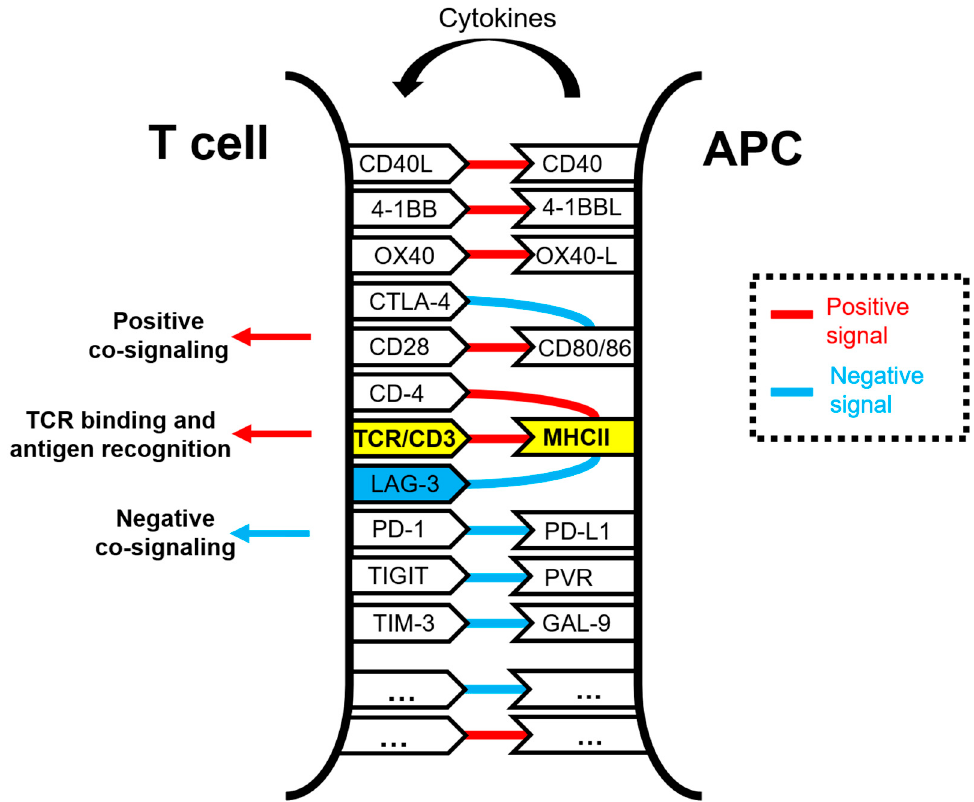
Figure 1. Schematic representation of the molecular interactions occurring within the immunological synapse between a T cell and an antigen-presenting cell (APC) during antigen presentation and T cell activation. The TCR/CD3 and MHC complexes are highlighted in yellow. Some of the well-known co-stimulatory and co-inhibitory receptor–ligand interactions are shown in the figure, linked by red lines for activating interactions and with blue lines for inhibitory interactions. Antigenic peptides presented by APCs loaded in MHC molecules are specifically recognized by the TCR, while other interactions take place simultaneously to deliver co-stimulatory and co-inhibitory signals. These interactions are integrated within T cells. The LAG-3 molecule is highlighted in blue.